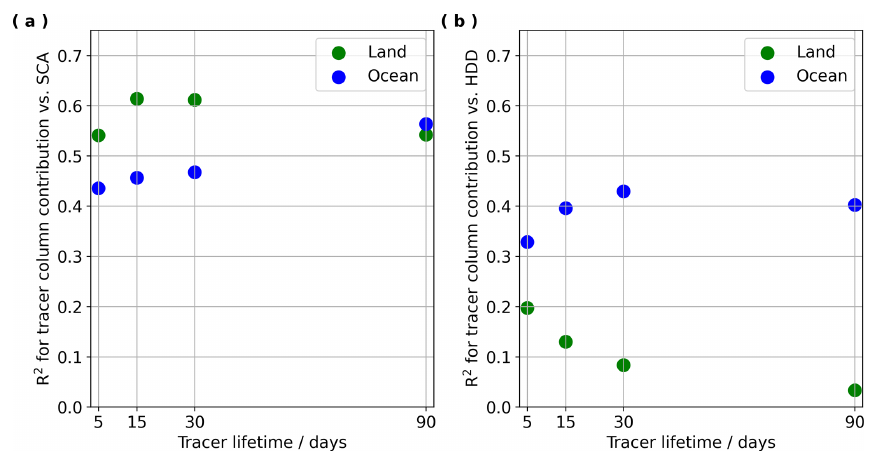
Figure 10. Panel (a) shows correlation coefficients for surface contact tracer contributions from land and ocean (mapped in Fig. 9) versus OCO-2 SCA (mapped in Fig. 4a), and panel (b) shows correlation coefficients for surface contact tracer contributions from land and ocean versus OCO-2 HDD (mapped in Fig.